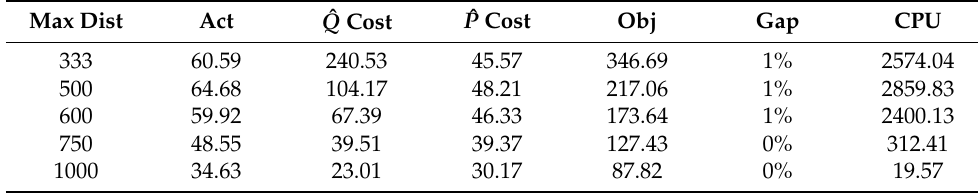
Table 7. Maximum distance variation